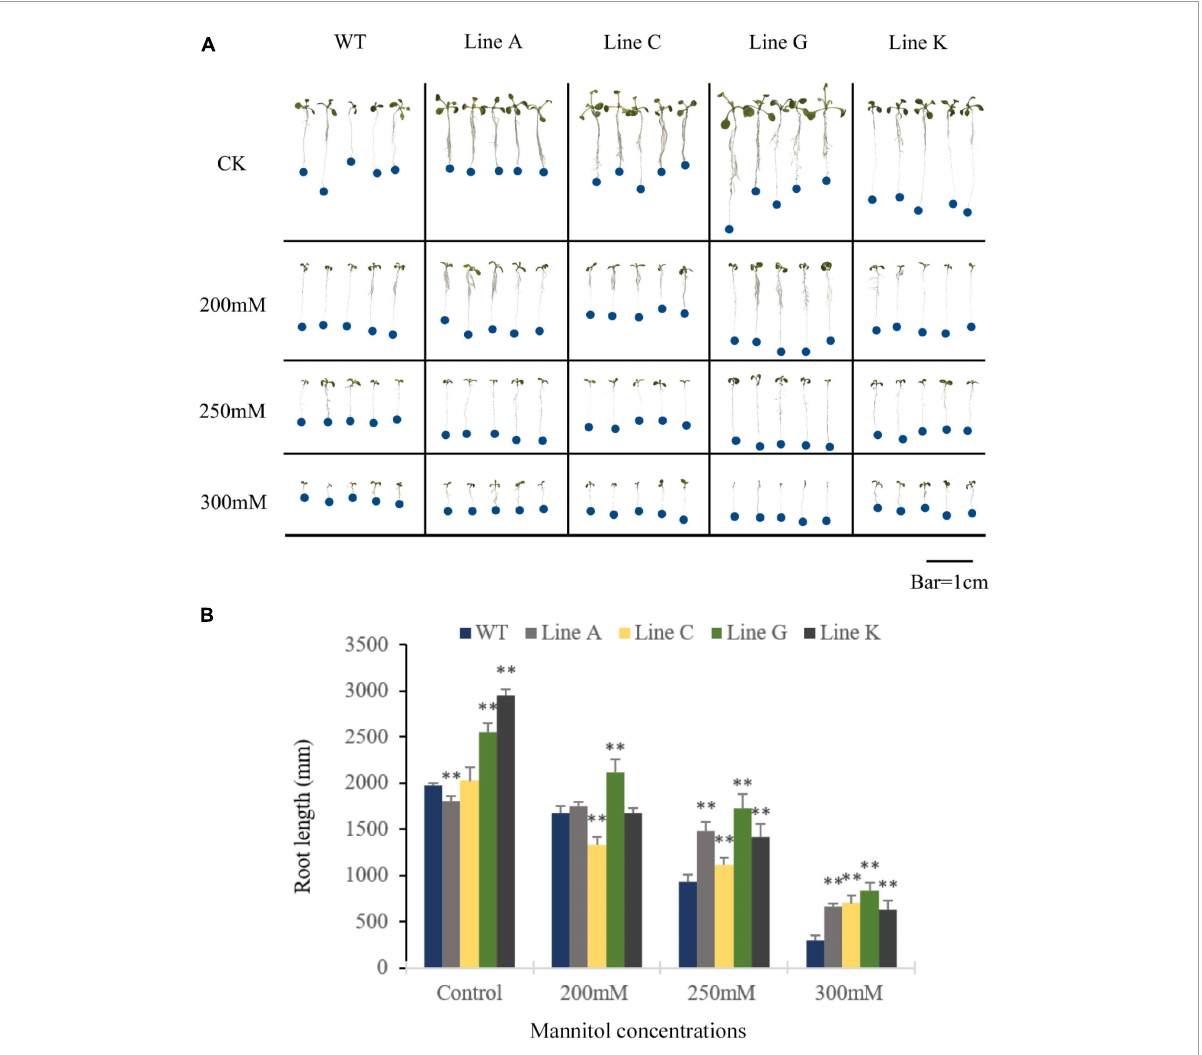
FIGURE3 Analysis of drought tolerance at the seedling stage. (A) Morphology of transgenic and WT seedlings grown on 1/2 MS medium for 9 days containing varying concentrations of mannitol. (B) The primary root length was measured and analyzed. Data are presented as mean and SD values of three independent experiments. Asterisks indicated significant difference ( ∗∗ P < 0.01) comparing to